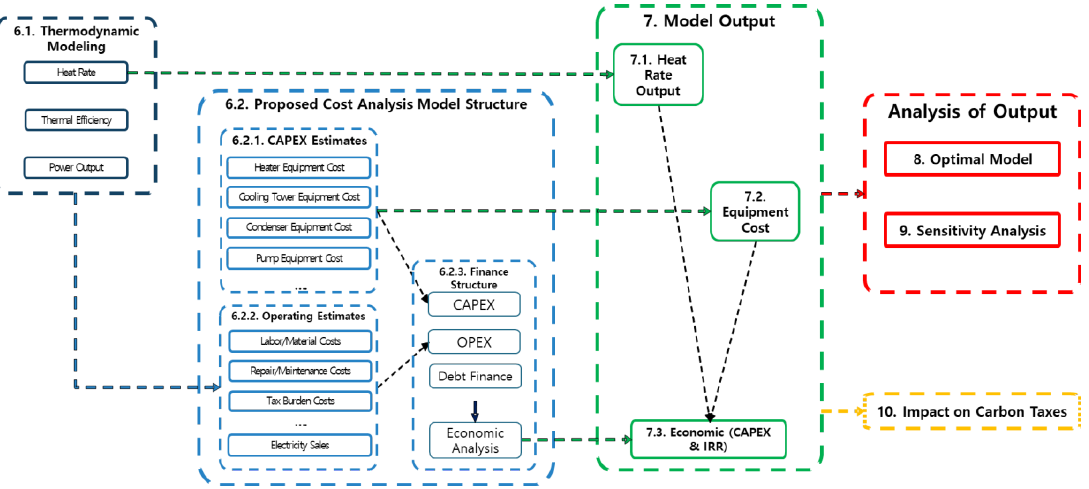
Figure 2. Research methodology flow. (Note: Numbers in the box reference the paper section numbers for ease of reader.).